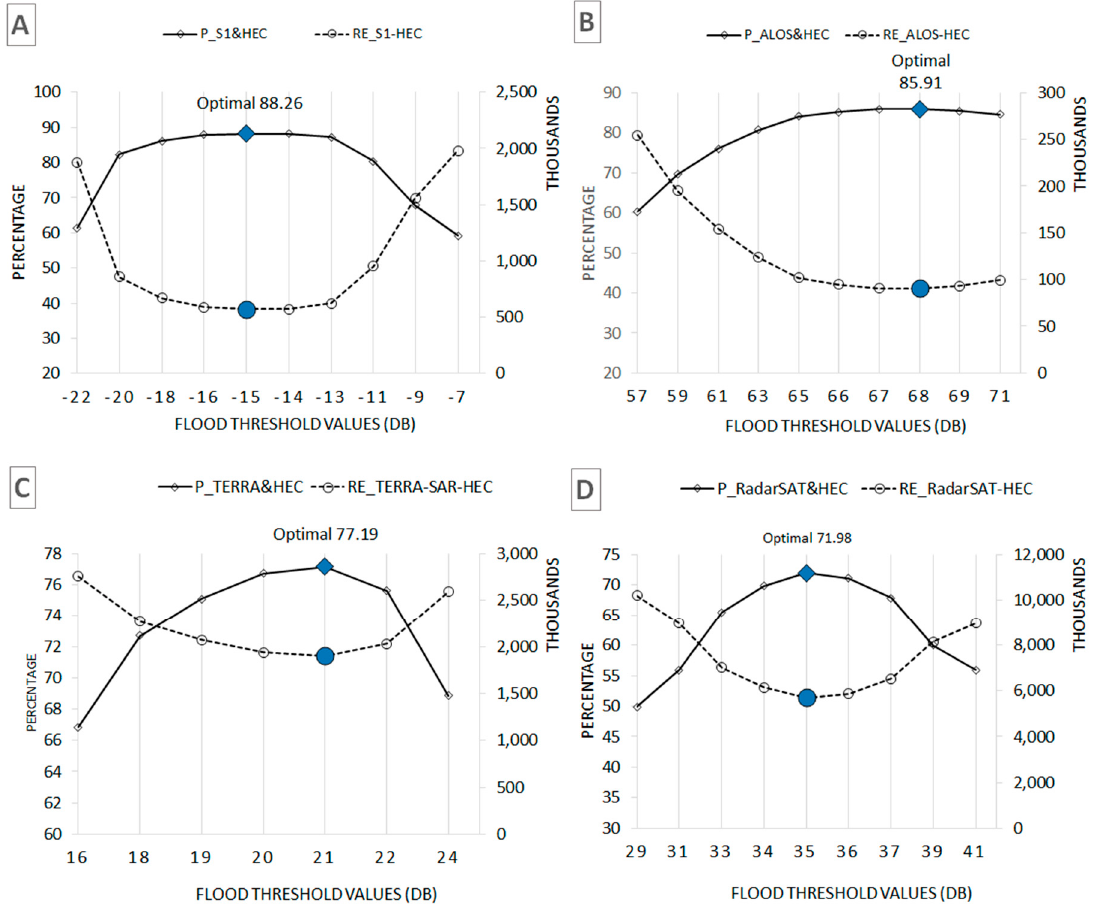
Figure 12. Graphical presentation of HST for ( A ) Sentinel-1, ( B ) ALOS PALSAR, ( C ) TerraSAR-X, and ( D ) RadarSAT-2 thresholding images of water extractions.